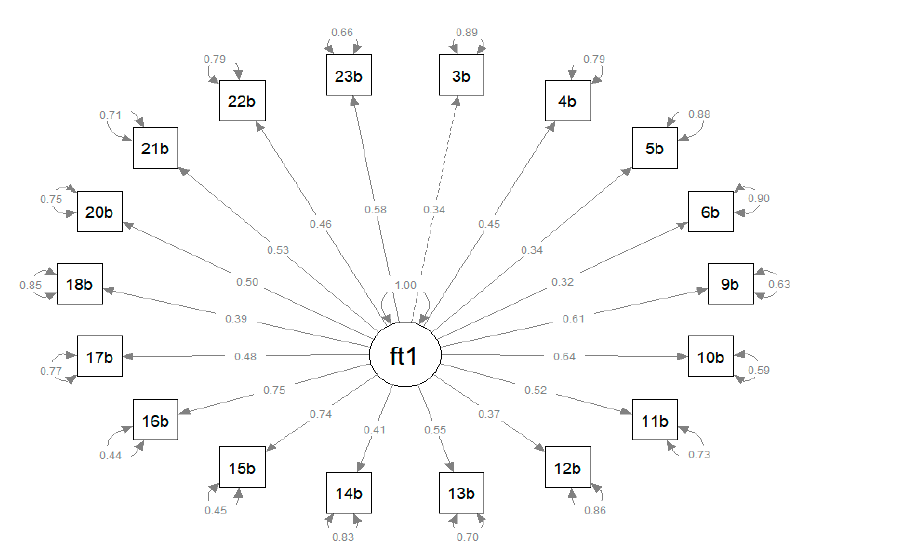
Figure 2. Path diagram of the confirmatory factor analysis and standardized loading of items of the version QODD 3.2a.